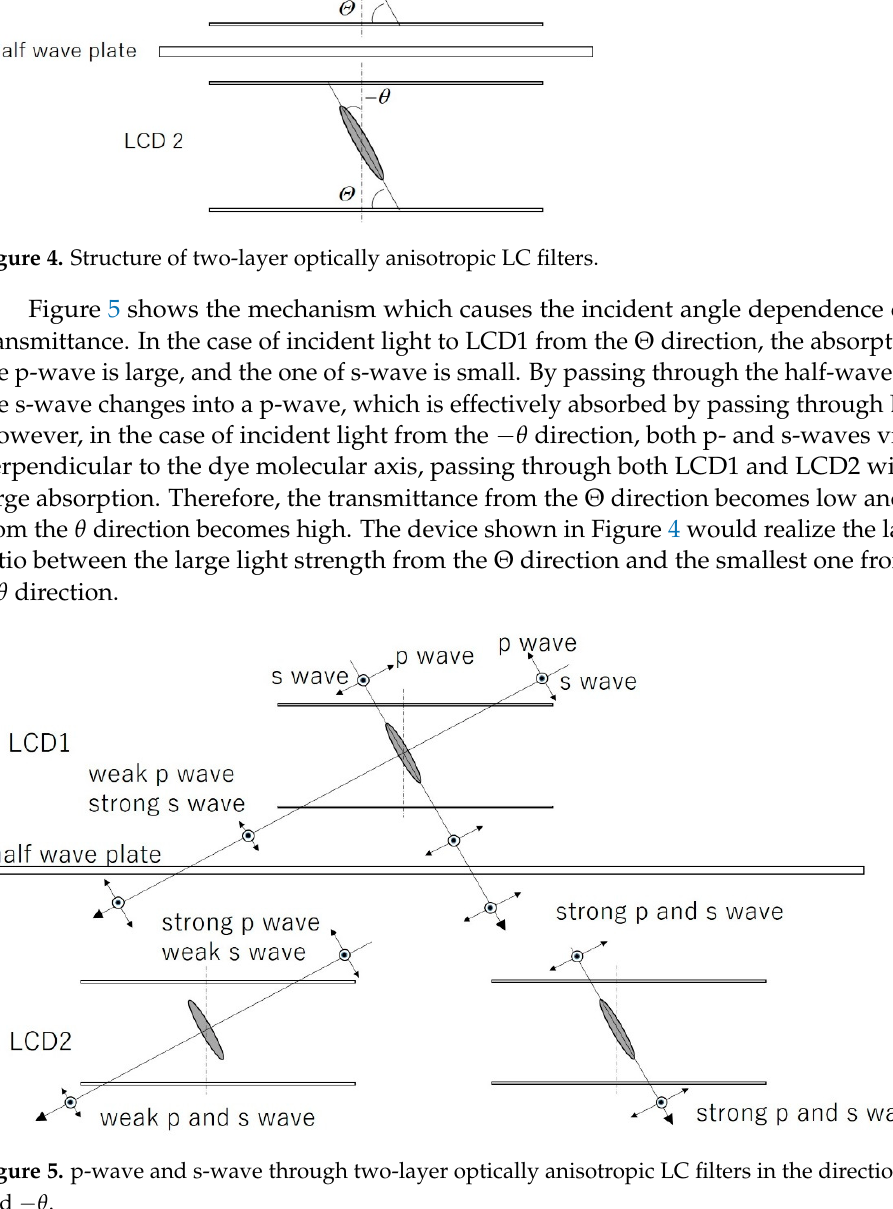
Figure 3. Light passing through the HAN or high pretilt angle LCDs from the incident angles of Θ and − θ.